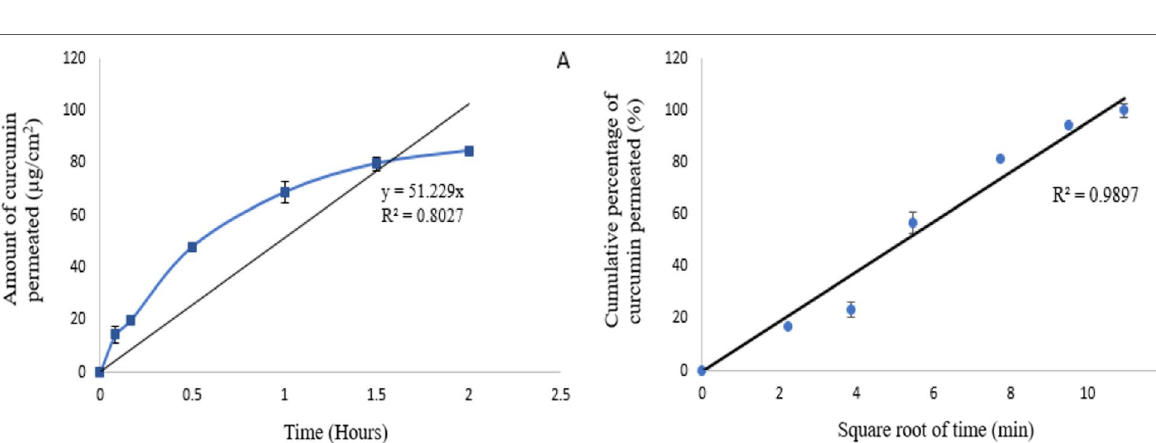
Fig. 3 Graph of amount of curcumin released against time in hours ( A ), graph of Higuchi release kinetics with percentage cumulative of drug released against square root of time ( B ) (All data sets ( p <